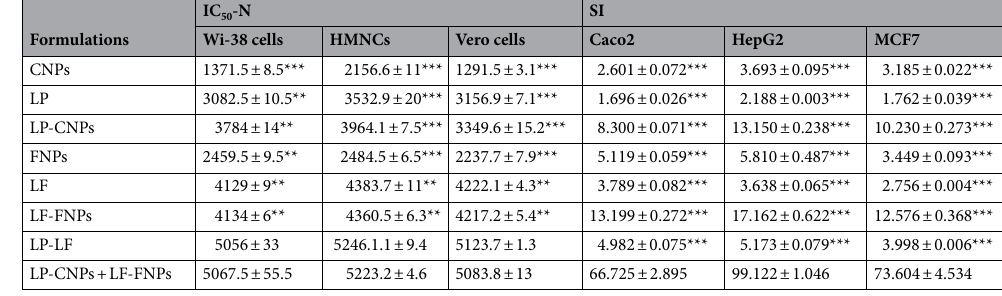
Table 2. IC 50 -N (μg/ml) and stimulation index (SI) of the prepared formulas. All values are expressed as mean ± S.E. LP-CNPs + LF-FNPs were compared to other formulas and considered statistically significant at p < 0.05*, p < 0.005**, p < 0.0005***. CNPs: CuO nanoparticles; FNPs: iron nanoparticles; LF: lactoferrin; LP: